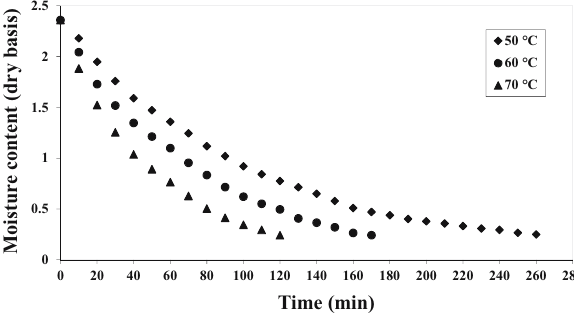
Figure 1: Experimental drying curves for convective drying of pomegranate arils under di ff erent air temperatures, in the form of dry basis moisture content versus drying time.